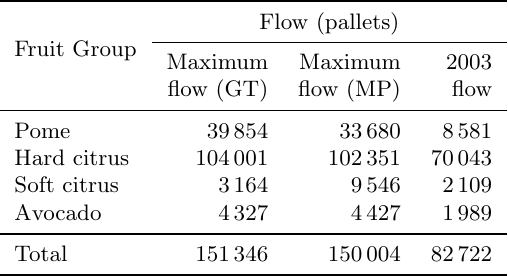
The maximum export volume (for the graph theoretic (GT) and mathematical pro- gramming (MP) models) of each individual fruit group in the winter scenario, compared to the actual export volumes of fruit during the 2003 season. Most of the pack houses would have to operate at full capacity to achieve the maximum flow solution in Table 7. In the Levubu region, pack houses for hard citrus, soft citrus and avocado are stretched to the limit to achieve a total export of 11 250 pallets of fruit. In Tzaneen only the hard citrus pack houses are bottlenecks, while there is capacity for an additional 142 pallets a week of avocados. The total export from Tzaneen may be as much as 16 425 pallets of fruit. In Hoedspruit (total export may be as high as 3 181 pallets of hard citrus and soft citrus), Kiepersol (total export could be 1 924 pallets of